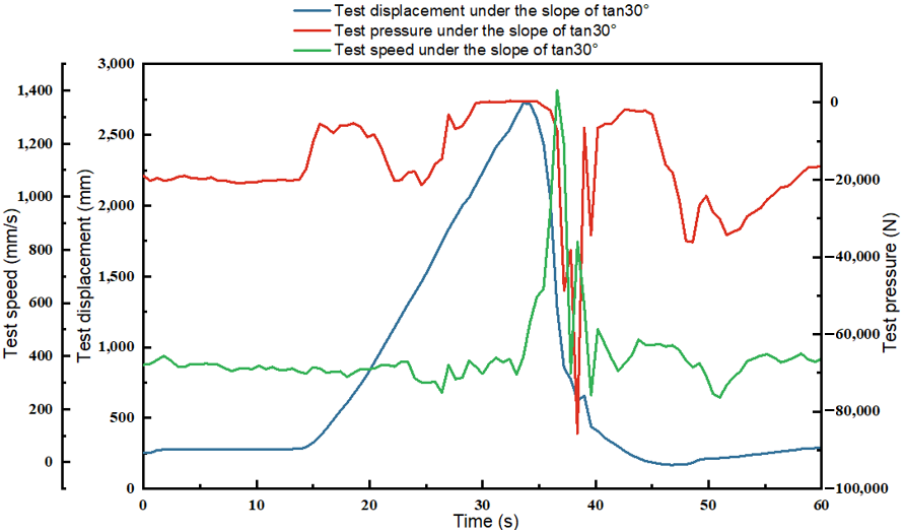
14 of 18 Figure 9. Obstacle climbing test of real vehicle. (Test equipment: ( a – c ); real vehicle test process under tan30° slope: ( d – f )).